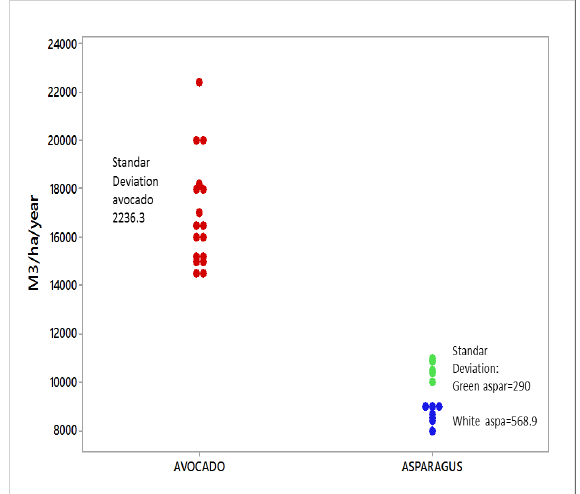
Figure 7. Water consumption (m3 ha−1 year−1) in avocado and asparagus farms of the Chavimochic irrigation project in December